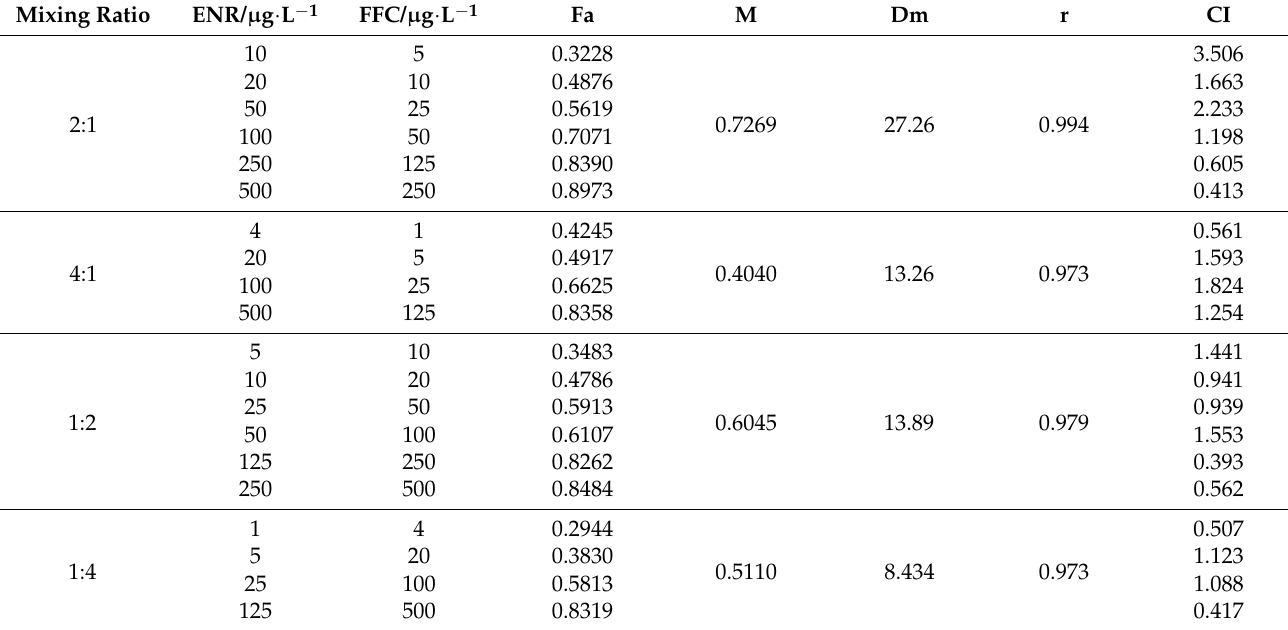
Table 5. CI values and parameters of median-effect plots of binary drug combination enrofloxacin and florfenicol (mixed at ratios of 2:1, 4:1, 1:2, and 1:4) against THLE-2 cells after 72 h